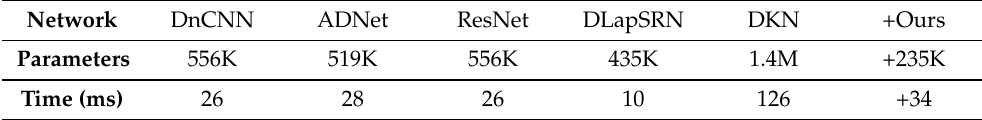
Table 1. Learnable parameters and timings of the networks in our experiments. Timings were measured using a NVIDIA Tesla V100 and AMD EPYC 7452 on a single 640 × 480 image (output size) from the NYU v2 dataset [33]. Network